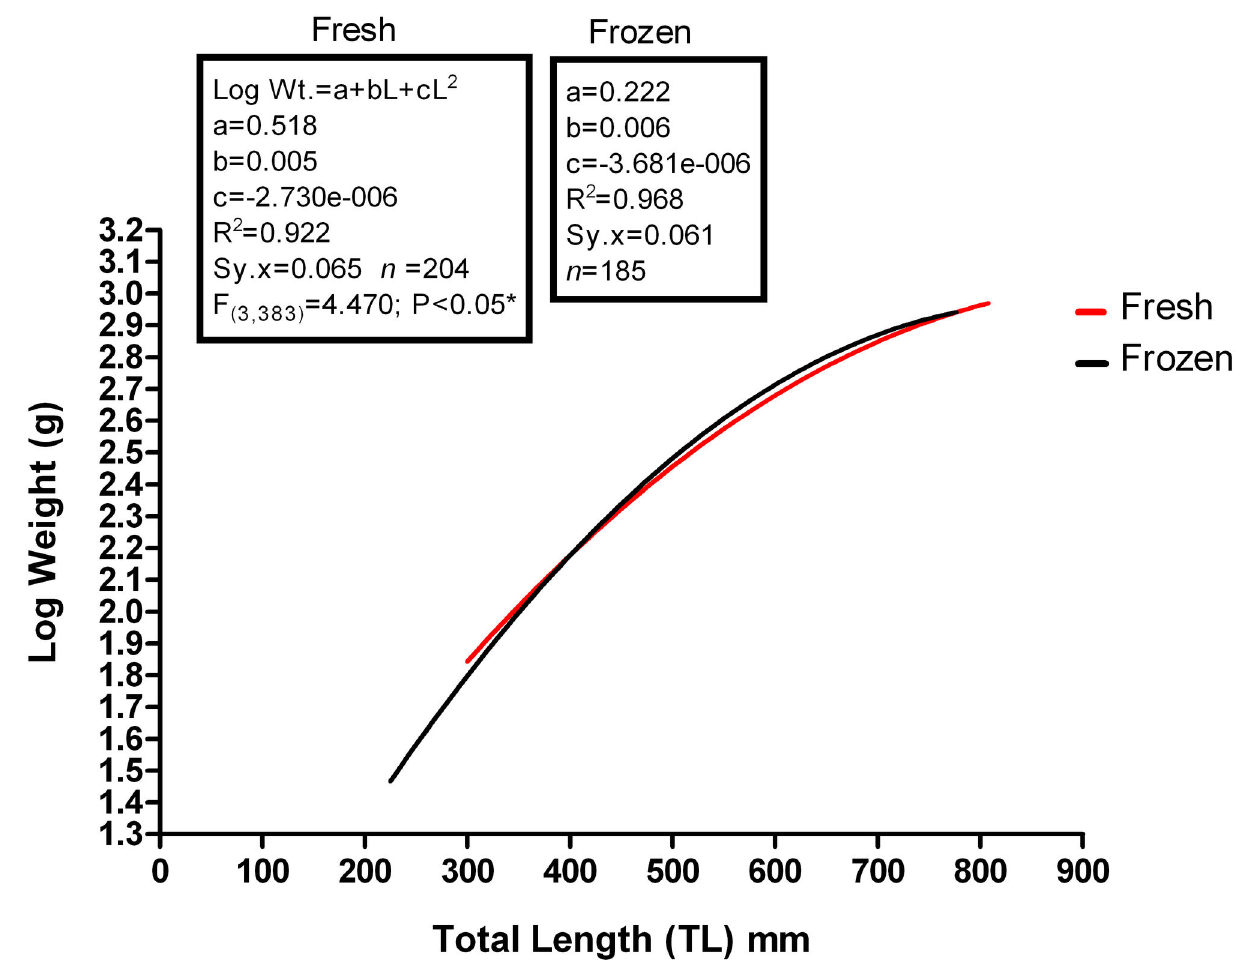
Figure 9. A comparison of fresh and frozen L:W curves. The curves are significantly different, with frozen specimens weighing slightly less at a given